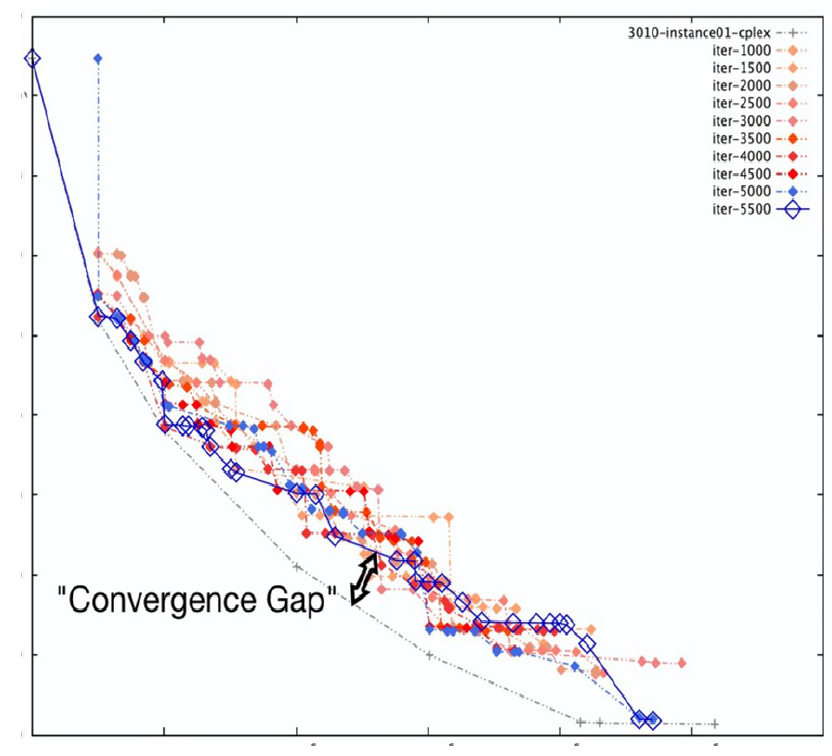
Figure 5. SMPSO algorithm struggles to converge into a true Pareto